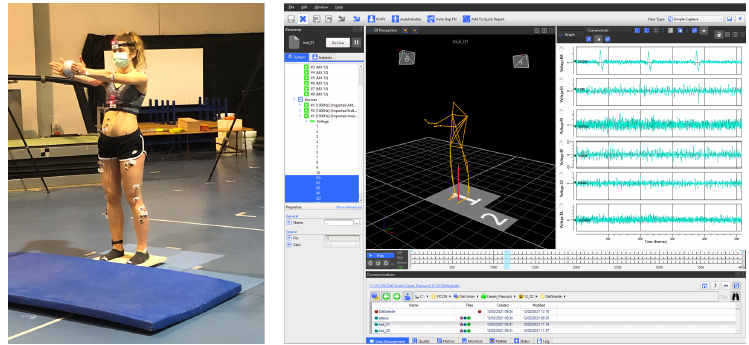
Figure 6. Experimental setup: the